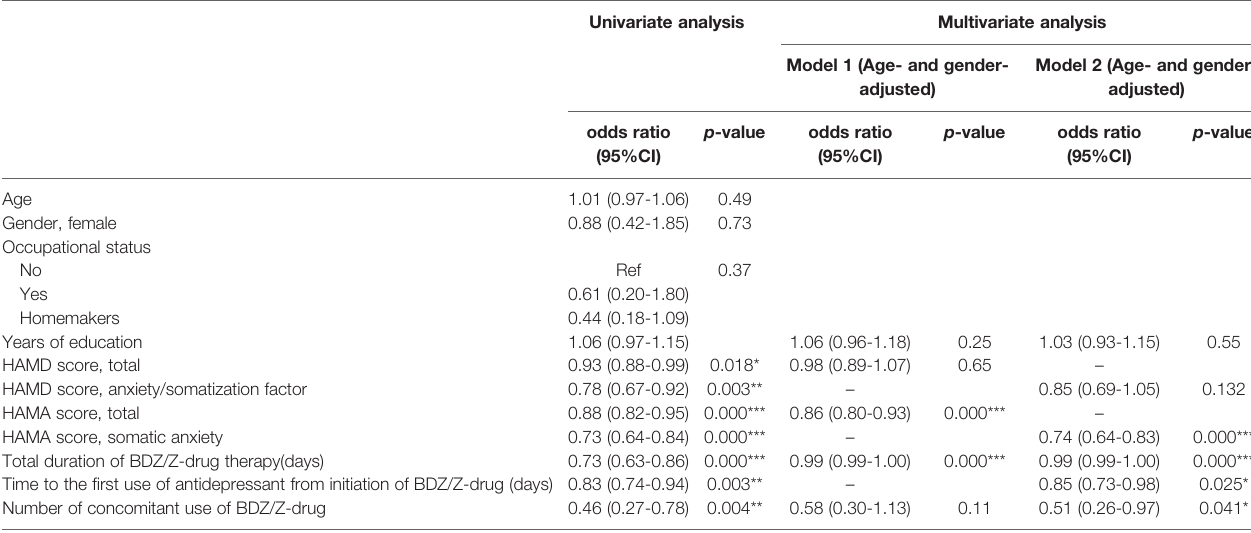
TABLE 4 | Factors associated with discontinuation of BDZ/Z-drug and successful switch to Melatonin CR in MDD patients with insomnia (univariate and multivariate